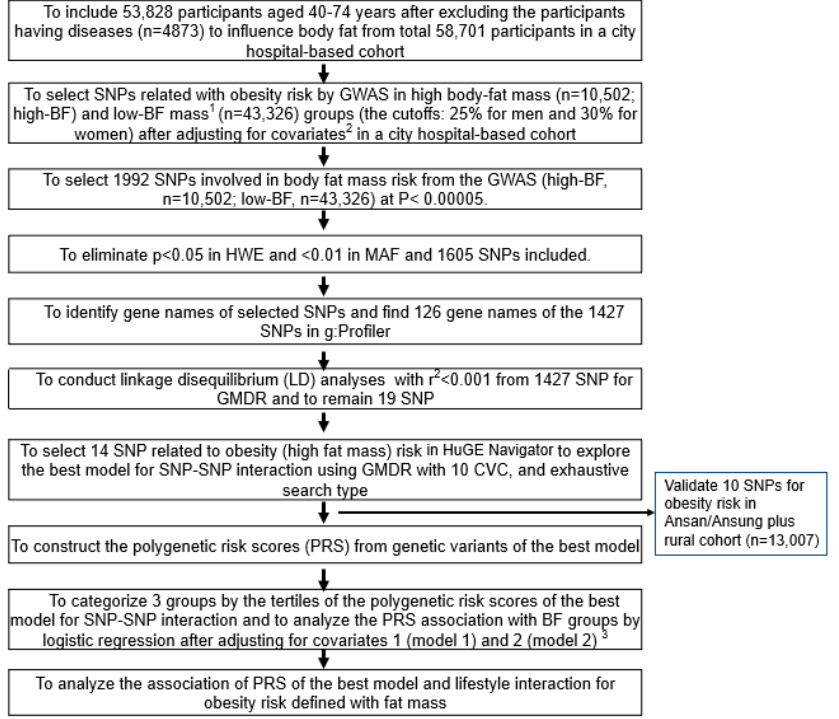
Figure 1. The scheme of searching the genetic variants related to body fat mass and polygenic risk factor (PRS) of the selected genetic variants’ interaction with lifestyles. 1 High body fat mass (obesity) was defined as body fat higher than 25% and 30% of body weight for men and women, respectively. 2 Covariates included age, gender, residence area, survey year, daily energy intake, and education and income levels. 3 Covariates for model 1 were age, gender, residence area, survey year, education, and income; those for model 2 were covariates for model 1 plus energy intake, alcohol intake, regular exercise, and smoking